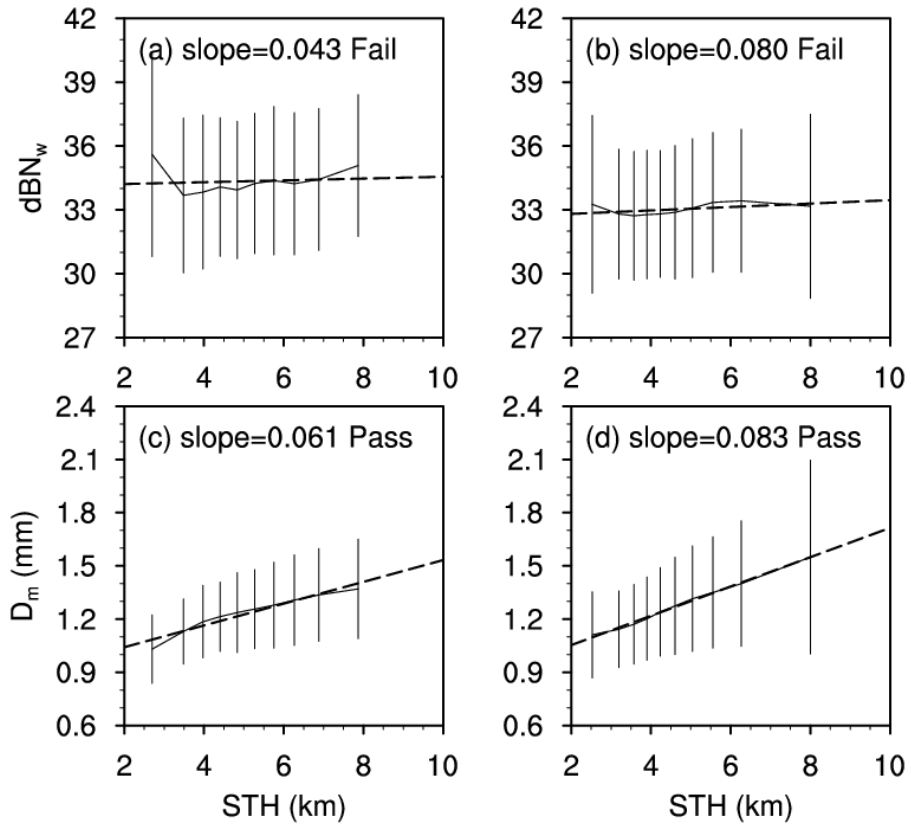
Figure 7. Relationship between STH and DSD: ( a , b ) STH vs. dBN w ; ( c , d ) STH vs. D m ; ( a , c ) 2020-TC; ( b , d ) September 2014 – September 2019. Bars represent the standard deviation; the dashed line is the line of best fit for 10 equal-sample points; the panel lettering of each sub-figure is followed by the slope of the line of best fit and whether it passes the 95% significance test.